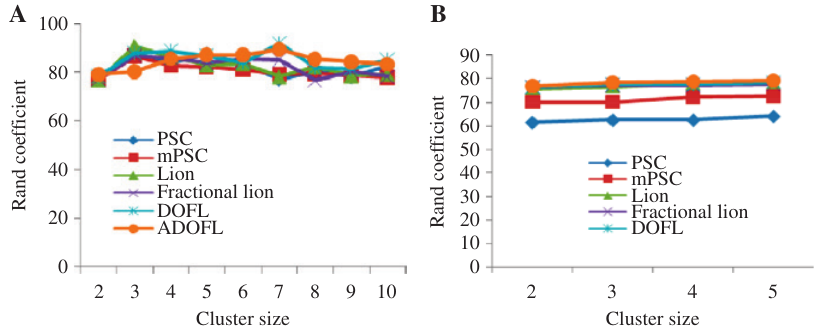
Figure 5: Rand Coefficient Analysis Curve. (A) Iris dataset. (B) Wine dataset.